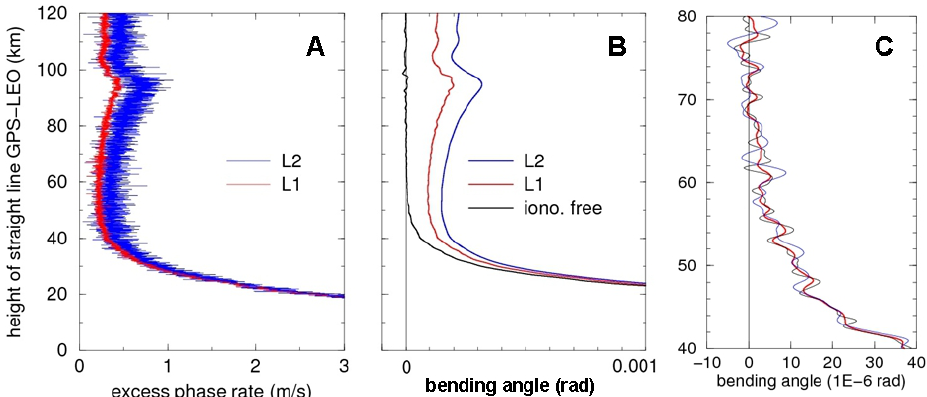
Fig. 2. Panel A : L1 (red) and L2 (blue) excess Dopplers; panel B : L1 (red), L2 (blue) and ionosphere-free L3 (black) bending angles; panel C : ionosphere free bending angles obtained by different smoothing of L4 Doppler (for details see text).